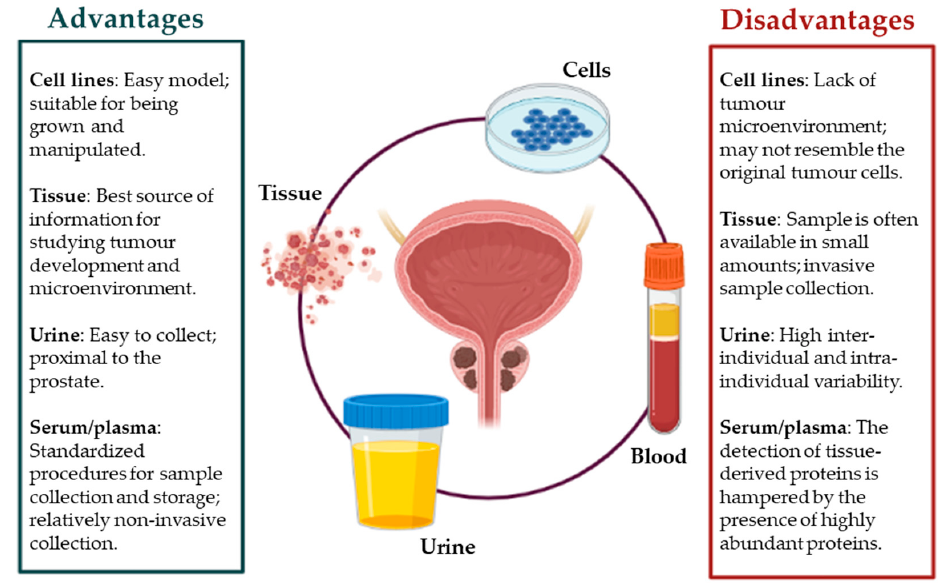
Figure 3. Advantages and disadvantages for each sample type.